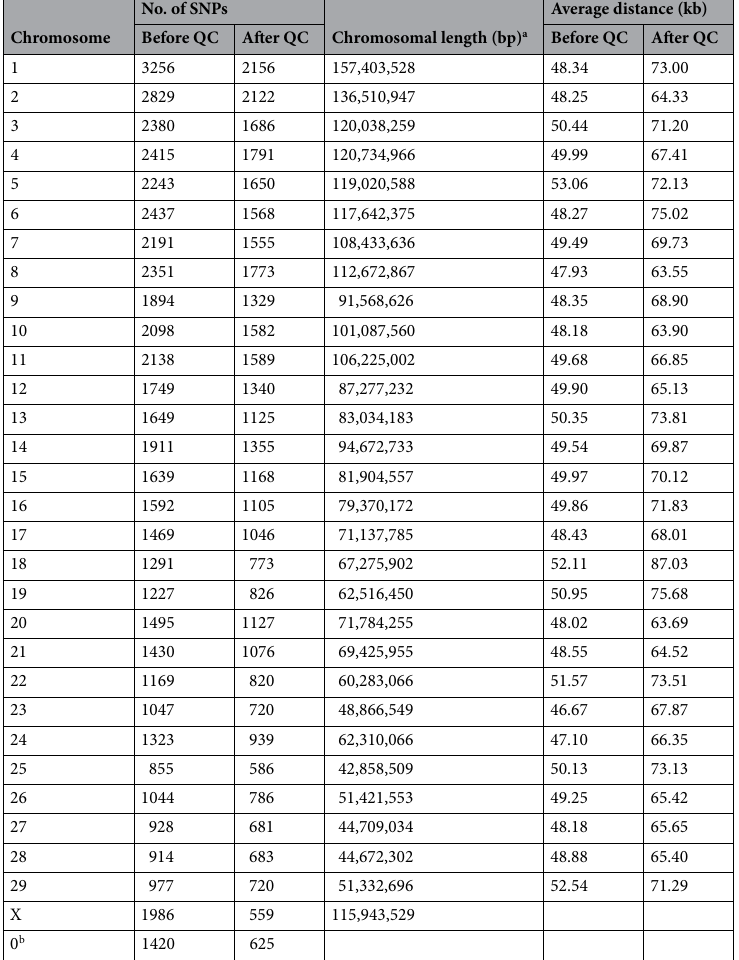
Table 1. Average distances between adjacent SNPs on each chromosome and distributions of SNPs before and after quality control (QC) measures. a Derived from latest goat genome sequence assembly (ARS1) (https:// www. ncbi. nlm. nih. gov/ assem bly/? term= Capra+ hircus). b Unallocated